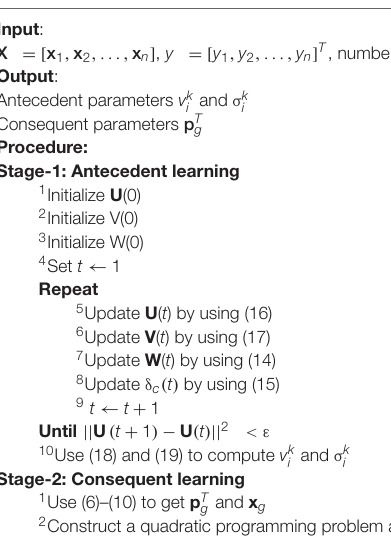
Algorithm 1 | Subspace clustering-based TSK fuzzy system.